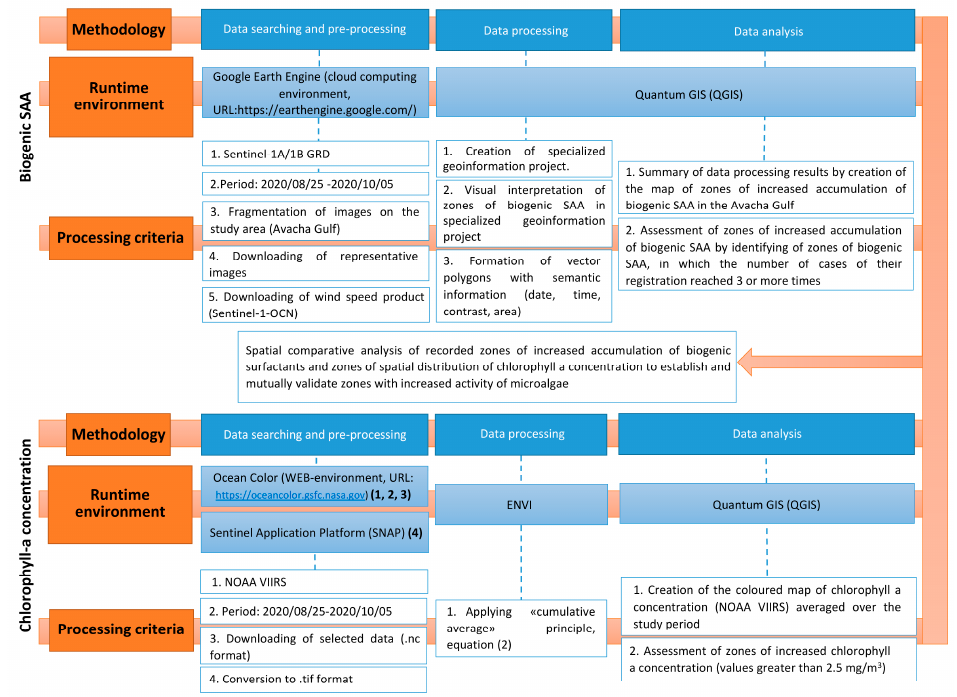
Figure 3. Flowchart of the experiment for processing Sentinel-1A/B radar satellite imagery.